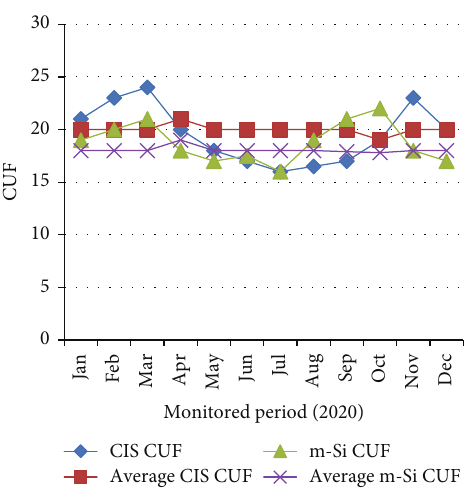
Figure 10: Monthly mean CUF for measured